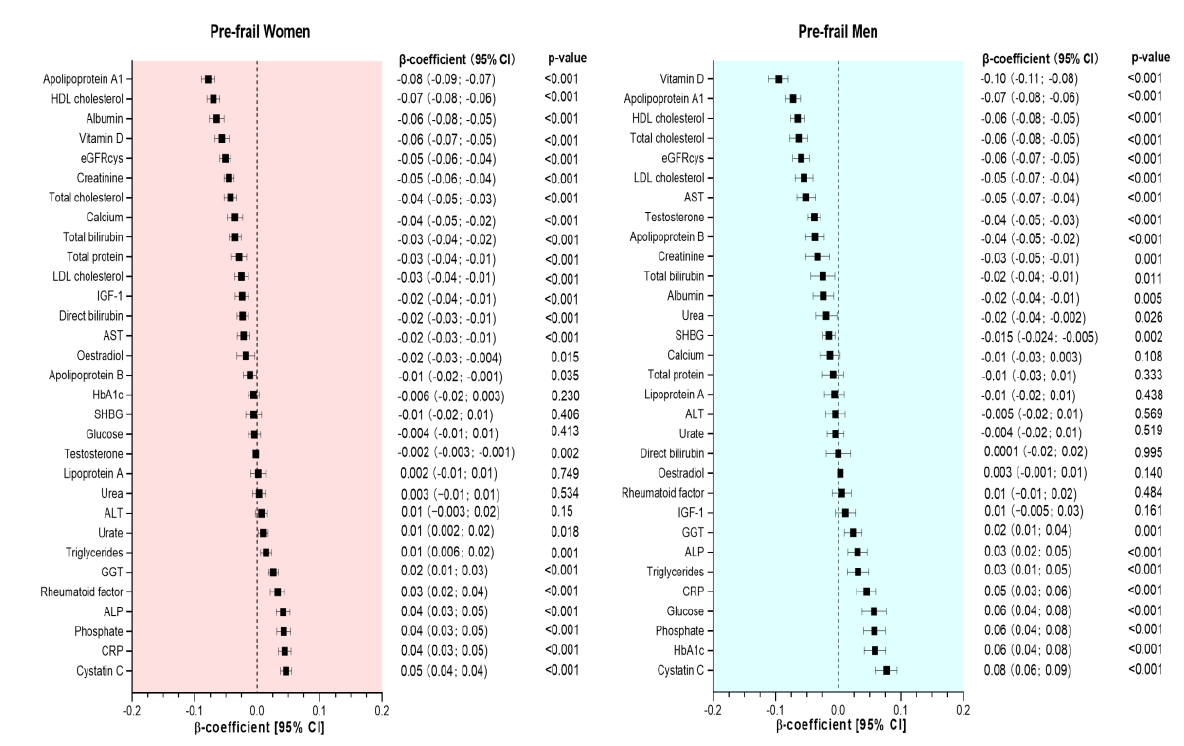
Figure 1. Association between biomarkers and pre-frailty by sex. Data presented as β -coefficient and its 95% CI. Non-frail individuals were considered as the reference group in each case. All analyses were adjusted for age, deprivation, BMI, smoking status, sleeping time, total sedentary time, morbidity count, medication, and dietary intake (alcohol, red meat, processed meat, fruit and vegetable intake).